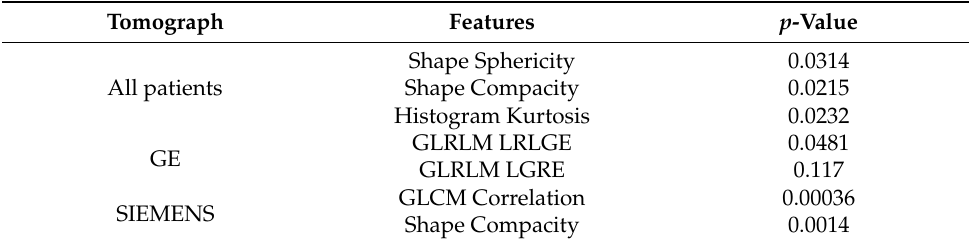
Table 3. Relevant features using the VOI. GLRLM LRLGE: Gray Level Run Length Matrix Long Run Low Gray-Level Emphasis; LGRE: Low Gray-level Run Emphasis; GLCM: Grey Level Co-occurrence Matrix.